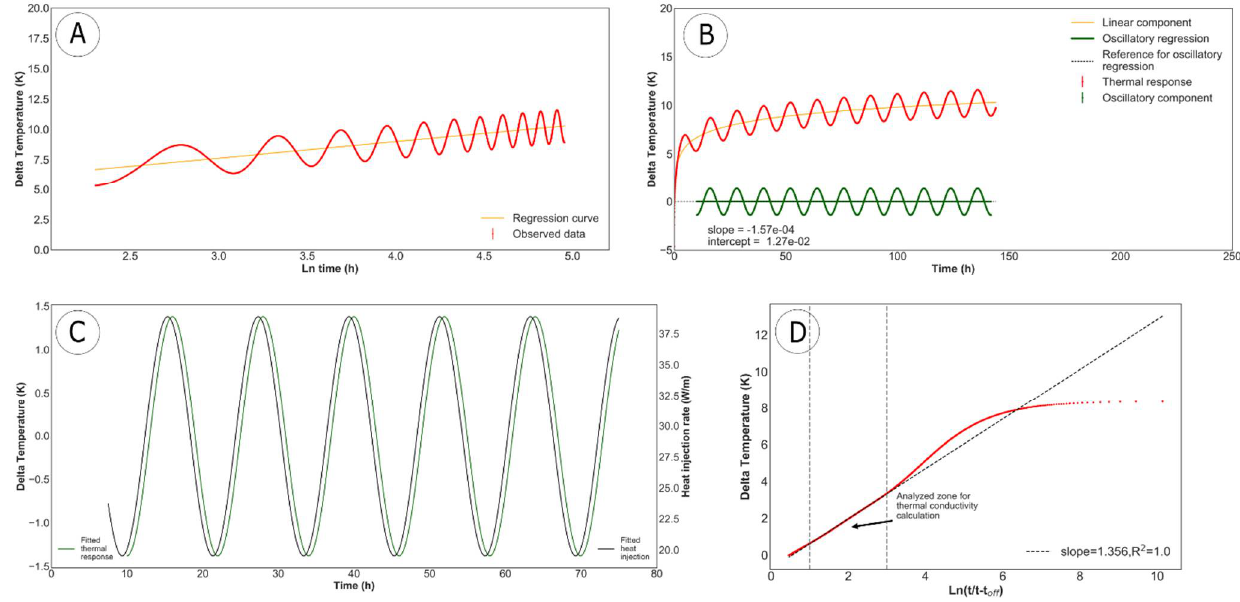
Figure 2. Steps for the analysis of an OTRT: ( A ) evaluation of λ heating and R ∗ via the slope method; ( B ) split of the linear and oscillatory components; ( C ) comparison of the oscillatory heat injection and the oscillatory thermal response; ( D ) analysis of the recovery period to estimate λ cooling .